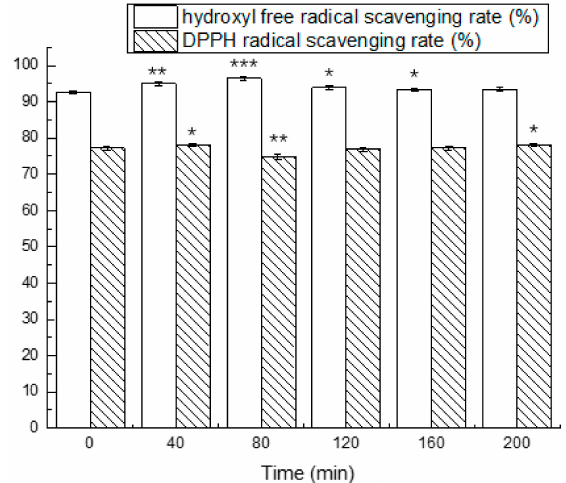
Figure 5. Effects of simulated gastric fluid on the hydroxyl free radical scavenging rate and DPPH radical scavenging rate at different times. The asterisks (*) indicate significant differences (*** p < 0.001, extremely significant; ** p < 0.01, very significant; * p < 0.05, significant.) of antioxidant activity in the simulated gastric fluid during different times compared to 0 min. Mean values ( n = 3) ± standard error are shown.